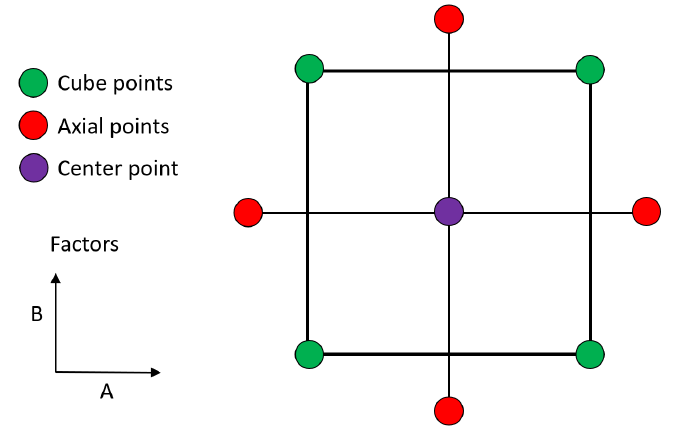
Figure 6. General scheme of central composite planning for two factors. Table 3. Cutting conditions for the different levels of the central composite planning.